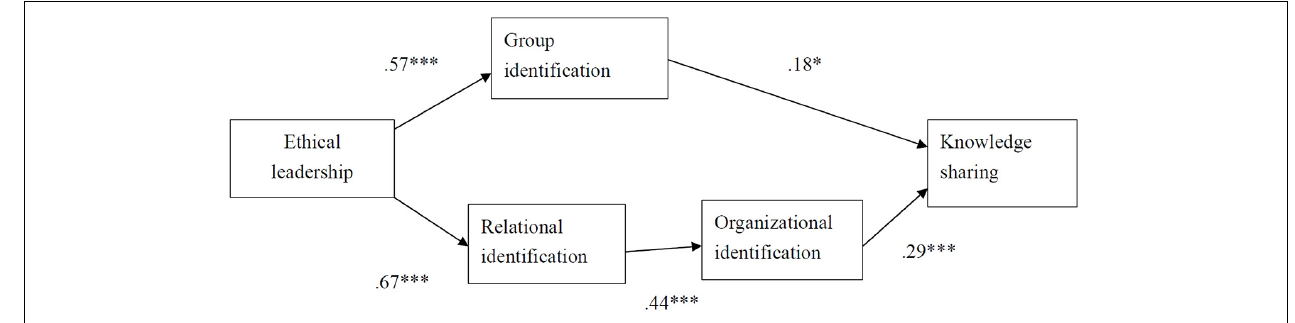
FIGURE 2 | Results of path analysis. * p < 0.05, ** p < 0.01, and *** p <